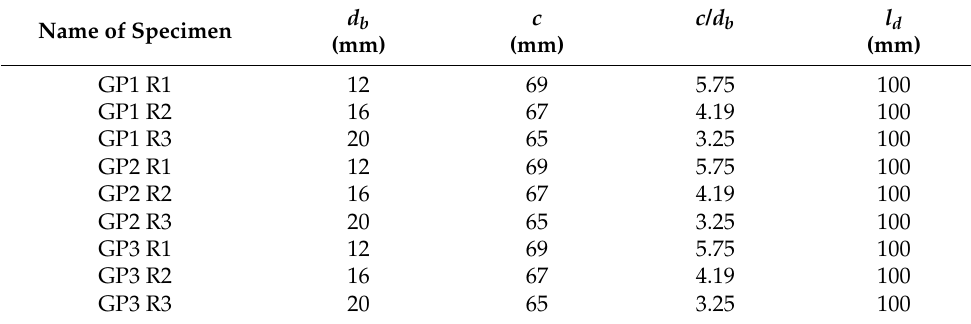
Table 4. Details of geopolymer concrete specimens.